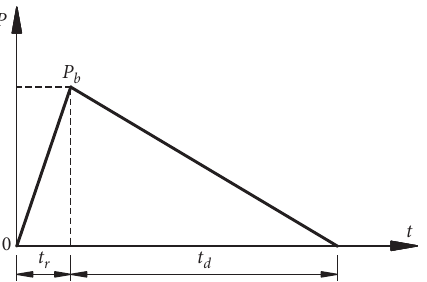
Figure 2: Time history curve of explosion pressure of equivalent